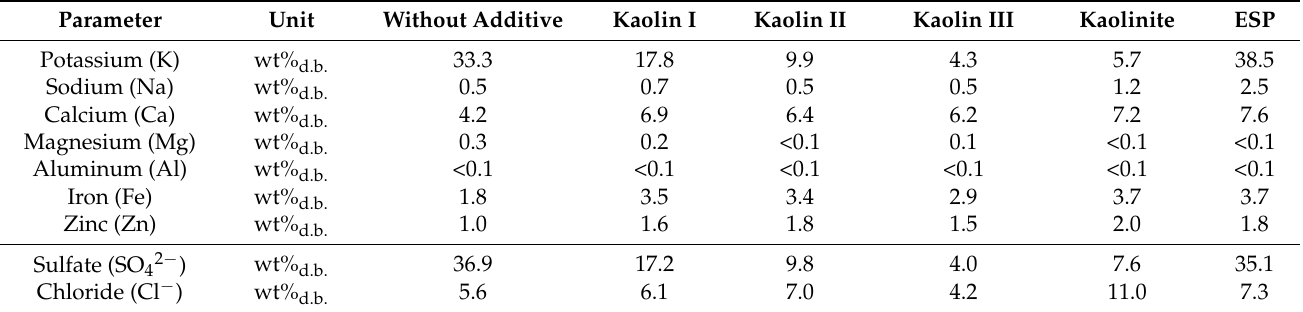
Table 3. Chemical compositions of total particulate matter emissions for the combustion of non- additivated (without and with electrostatic precipitator (ESP)) and additivated (0.5 wt% Kaolin I, Kaolin II, Kaolin III and Kaolinite) wood chips (d.b.: dry TPM